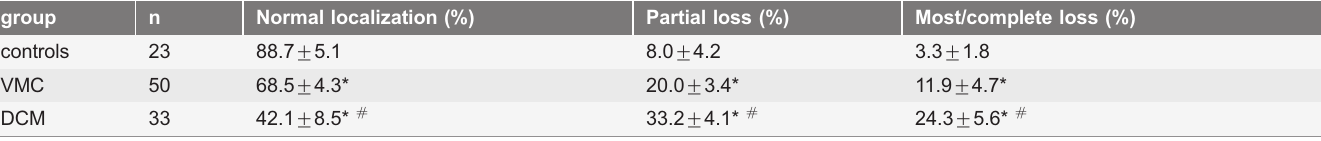
Table 4. The loss rate of mitochondrial membrane phospholipids in lymphocytes of VMD patients.